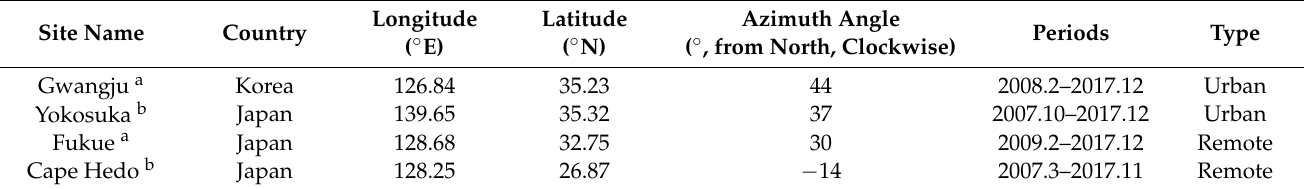
Table 1. Detailed information of